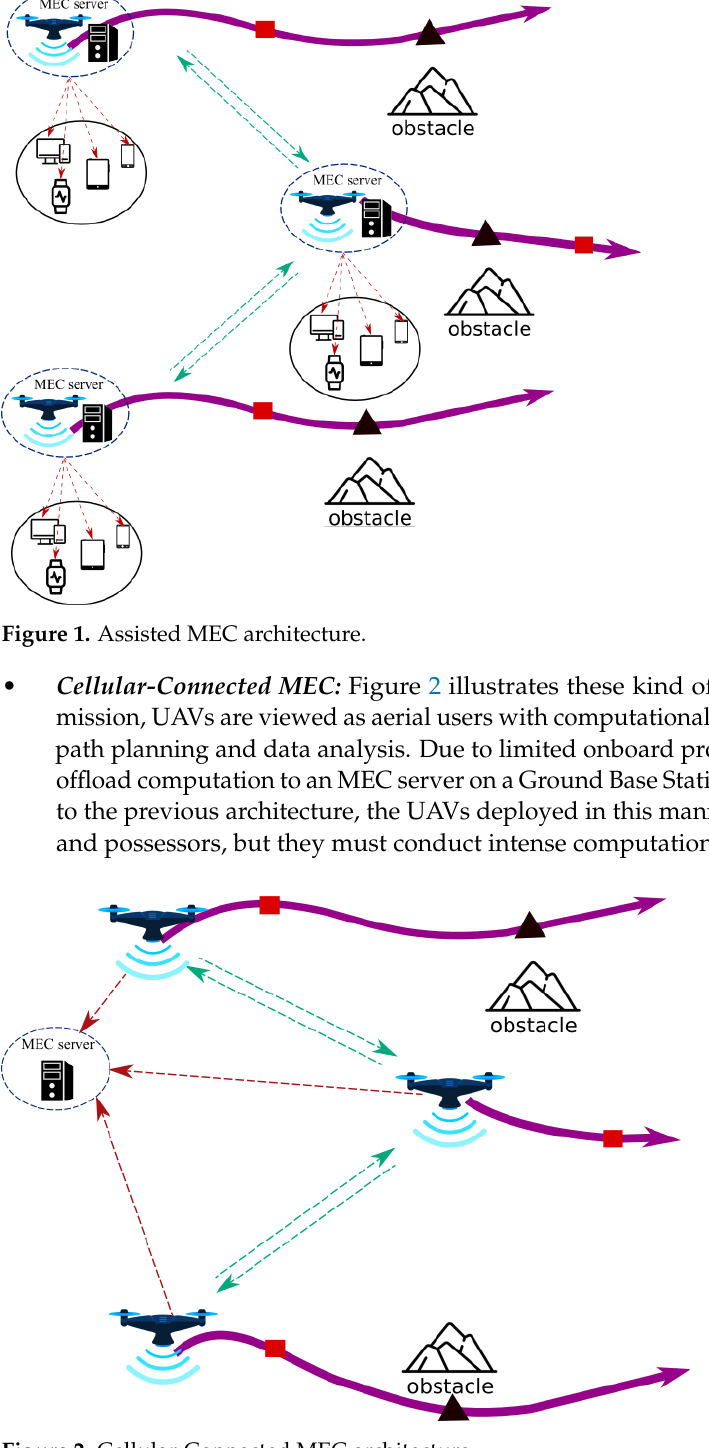
Figure 2. Cellular-Connected MEC